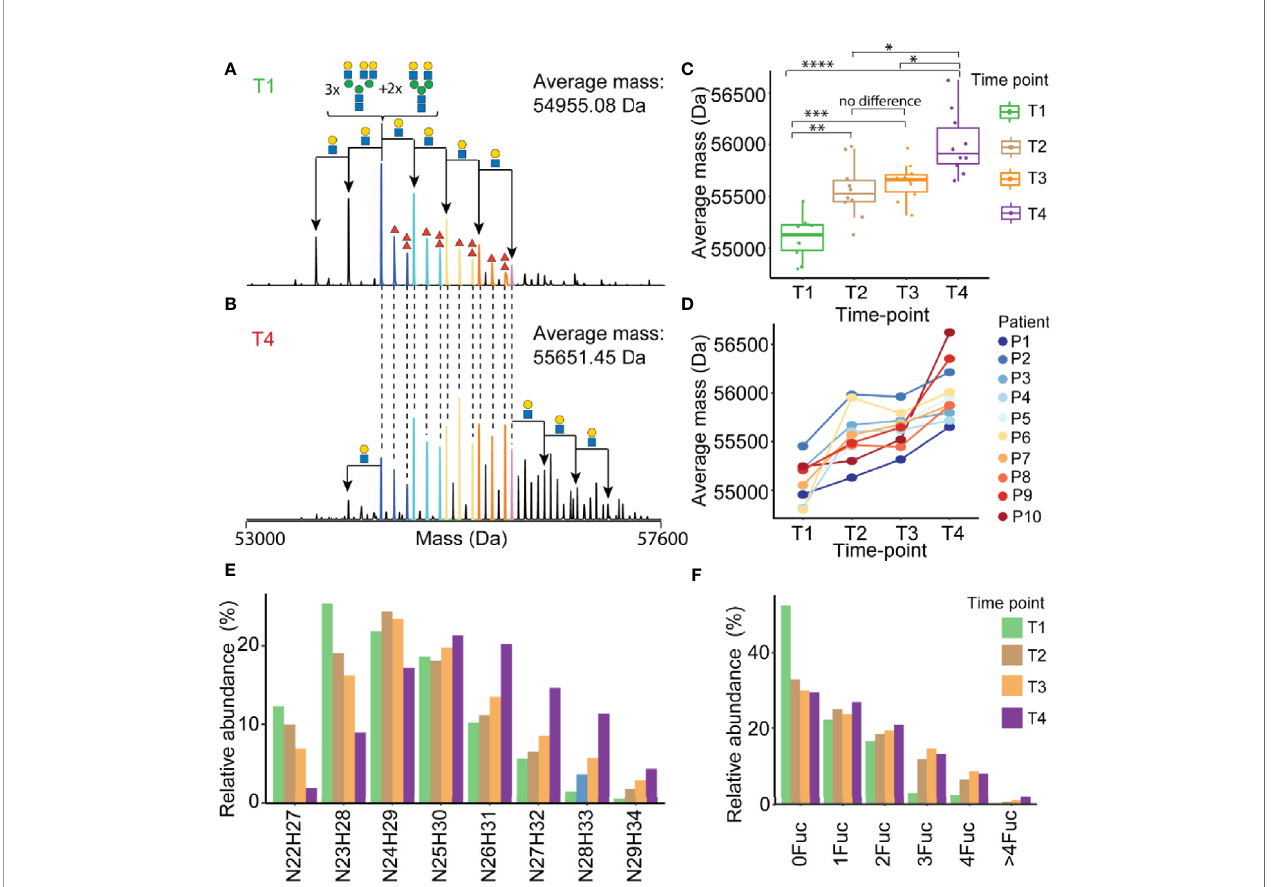
FIGURE 3 | Alterations in a -1-antichymotrypsin glycosylation following sepsis prolong over time. Illustrative deconvoluted native mass spectra of desialylated AACT obtained at T1 and T4 are shown in (A , B) , respectively (for patient 1). The likely glycan compositions of the most abundant signals are annotated in (A) , whereby the HexNAcHex shifts from the most abundant peak are denoted with black arrows. Red triangles denote the presence of additional fucose moieties. Overlapping peaks in the spectra between (A , B) are color-coded, and the weighted average mass (WAM) is denoted in the upper right corner. WAMs for desialylated AACT for all patients and all time-points are shown in (C) represented in Boxplots and the * denote the p values from ANOVA analysis where *<0.05, **<0.01, ***<0.001, and ****<0.0005, and concomitant “ spaghetti ” plots connecting each patient ’ s data are depicted in (D) . Relative abundances of AACT glycoproteforms of patient P1 with the same HexNAcHex (N=HexNAc, H=Hex) or Fuc count, potentially distributed over 5 N-glycosylation sites, are depicted in (E , F) , respectively. An overview of the abundances of these glycoproteoforms in AACT for all other patients is provided in Supplementary Figure 4